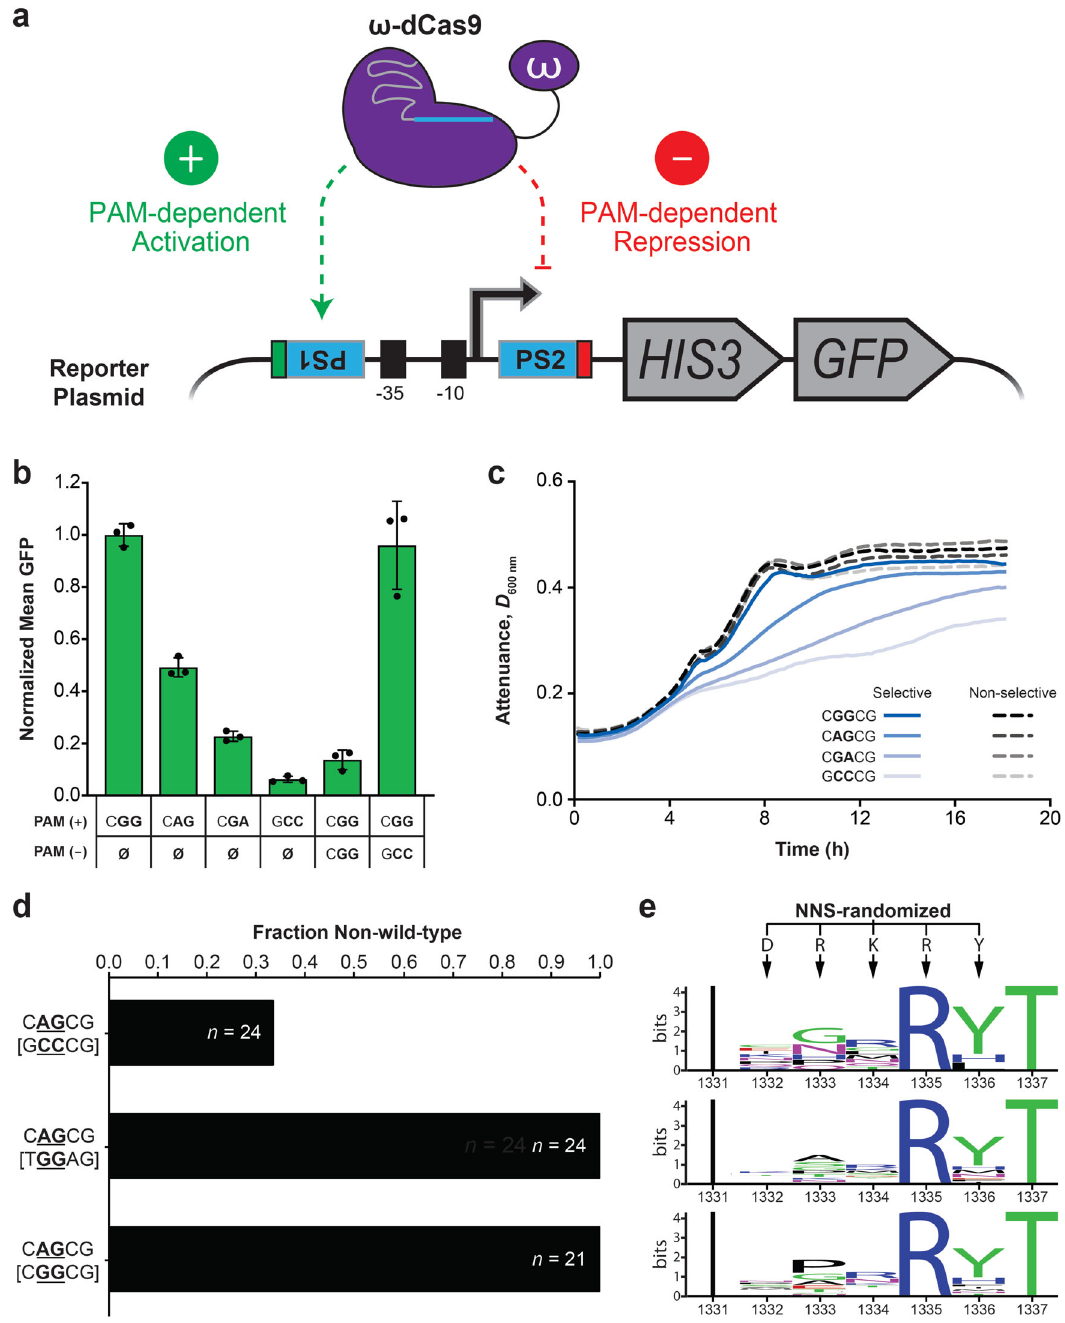
Fig. 1 B1H-based dual-selection system for directed evolution of Cas9 ’ s PAM speci fi city. a Schematic summary of the ω -dCas9 dual-selection system. Expression of the reporter plasmid ’ s synthetic HIS3/GFP operon is driven by transcription from an upstream lac core promoter ( − 10 and − 35 boxes). ω -dCas9 ’ s PAM-dependent interactions with two identical protospacers (PS1 and PS2) upstream and downstream of the promoter license activation and dominant repression, respectively. PAM positioning adjacent to each protospacer is indicated in green or red. b GFP fl uorescence measured from E. coli cells with Wt ω -dCas9 and different reporter plasmid con fi gurations. PAM sequence at the upstream ( + ) or downstream ( − ) protospacer is indicated; Ø denotes absence of the protospacer. Normalized mean values were calculated from populations of single cells analyzed by fl ow cytometry. Error bars, mean ± s.d. ( n = 3, biological replicates). c High-resolution growth monitoring of Wt ω -dCas9 cultures with the single-target reporter plasmids tested in panel b . Minimal media were supplemented with 8 mM 3-AT (selective) or 0.1% histidine (non-selective). Attenuance ( D 600 nm ) measurements plotted at each time point represent the average from three biological replicate cultures grown in parallel. d Bar plot representing the fraction of non-Wt PID sequences recovered from three selection experiments with the indicated reporter plasmid PAMs (the counterselection PAM is bracketed). The total number, n , of complete sequences recovered in each experiment is noted on the bars. Recoded Wt sequences were not detected in these experiments. e WebLogo 37 summaries of NNS-randomized residues identi fi ed in non-Wt sequences from the experiments in panel d . Only eight (non-Wt) sequences were included for the top plot. Source data are available in the Source Data fi le.